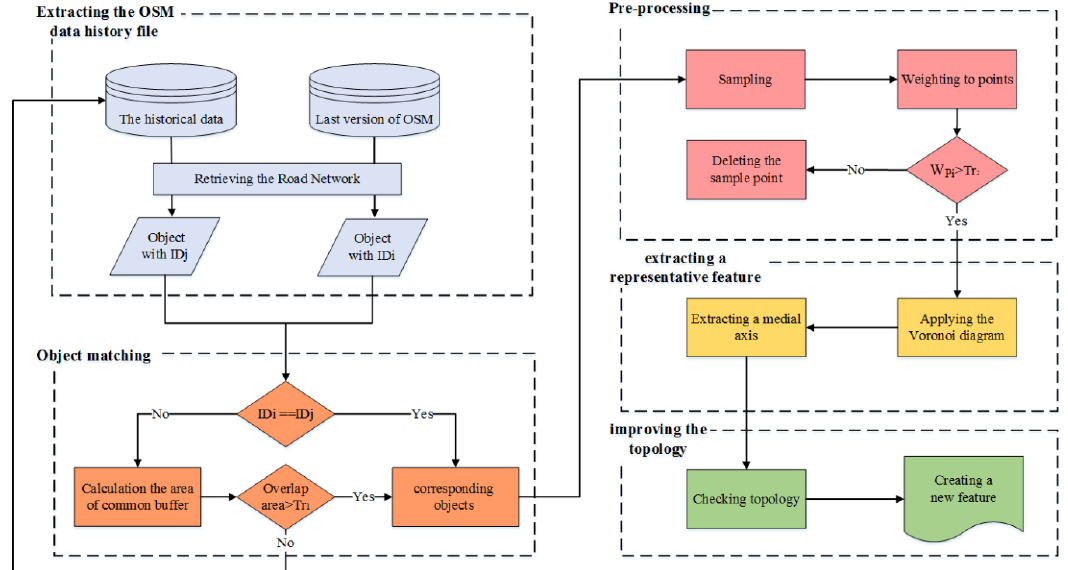
Figure 8. Flowchart of the implementation of the proposed method .